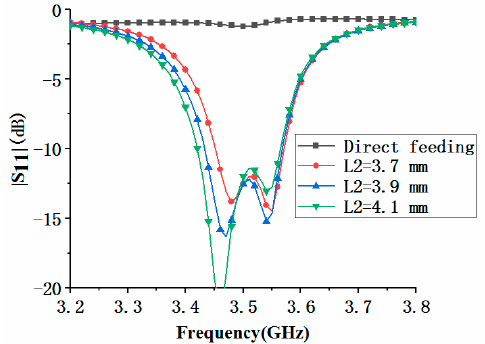
Figure 5. | S 11 | of the antenna element with di ff erent feeding Figure 5. |S 11 | of the antenna element with different feeding methods.